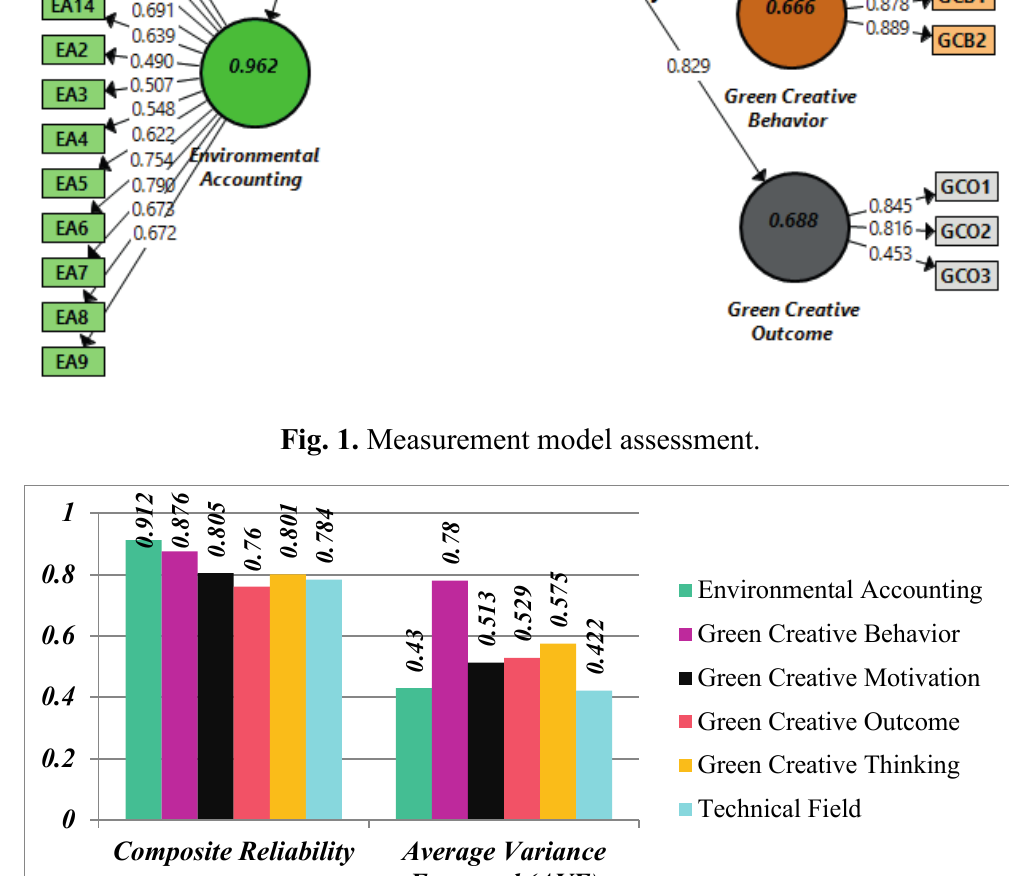
Fig. 2. Reliability and validity